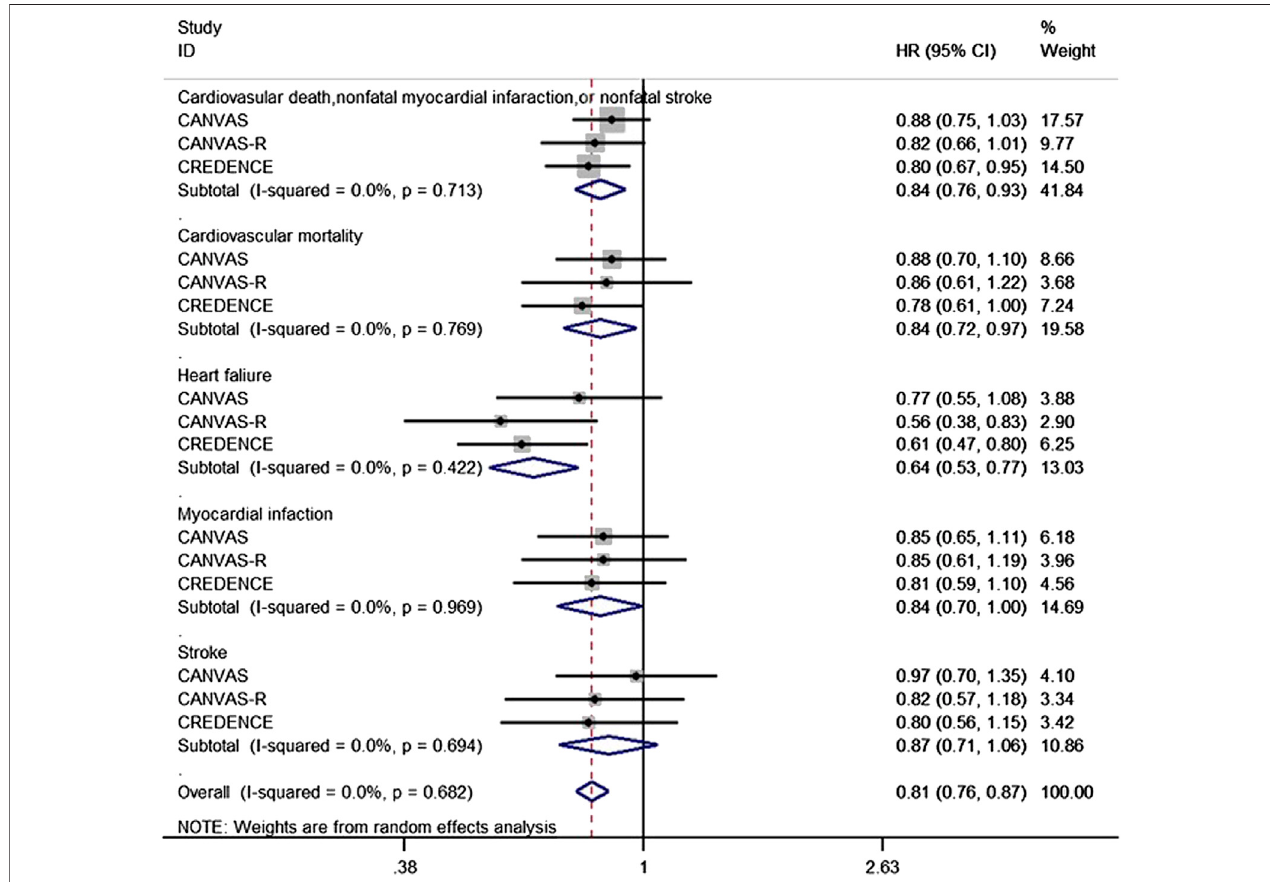
FIGURE3| Forestplotoftheeffectofcanagli fl ozinonthecompositeofcardiovasculardeath,cardiovascularmortality,heartfailure,Myocardialinfactionandstroke of the T2DM participants.